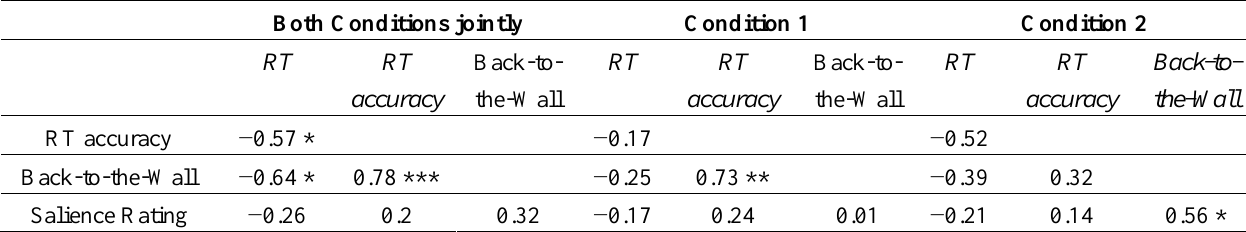
Table 2. Correlation matrix for picture-oriented